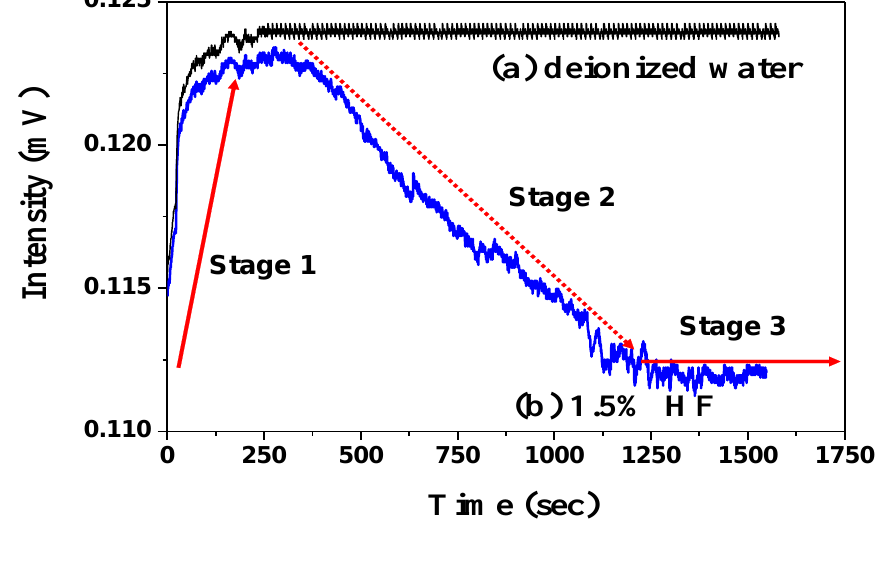
Figure 5. Dynamic responses of SiO HF (1.5%), respectively (the bulk SiO solution, after standing for 3